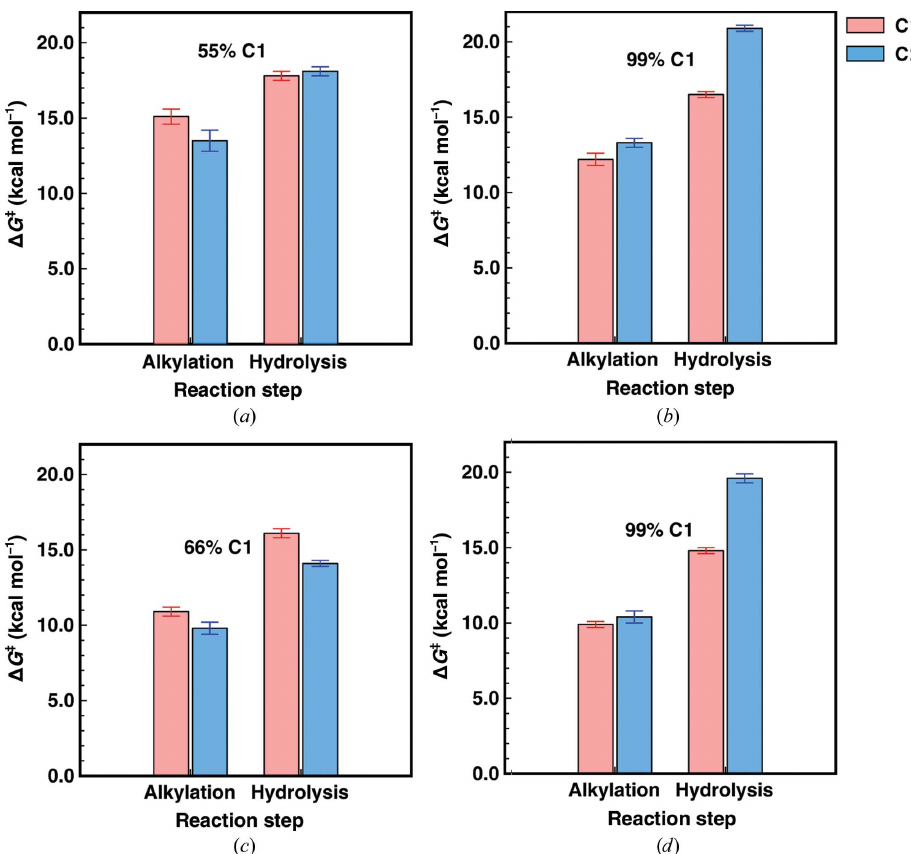
Figure 8 Calculated activation free energies for the alkylation and hydrolysis steps in the StEH1-catalyzed hydrolysis of 1a bound in the preferred of the two binding modes shown in Fig. 2. All values are averages and standard errors of the mean (shown as error bars) over 30 individual trajectories. Shown here are the reactions catalyzed by wild-type StEH1 ( a , b ) and R-C1 ( c , d ) for the ( R , R )-enantiomer ( a , c ) and the ( S , S )- enantiomer ( b , d ). The experimentally observed regioselectivies are indicated for each system (see Table 1). The corresponding raw data are shown in Table 3 and the full free-energy profiles for the preferred binding modes are shown in Fig.